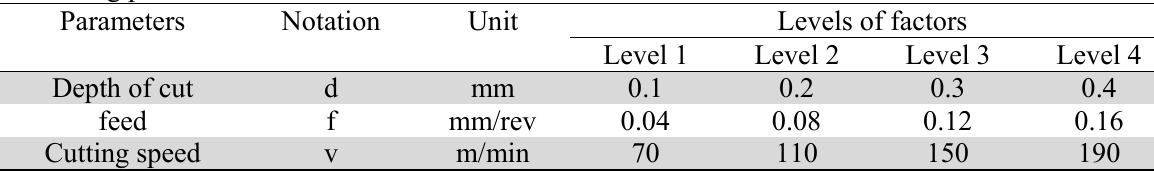
Machining parameters and levels.